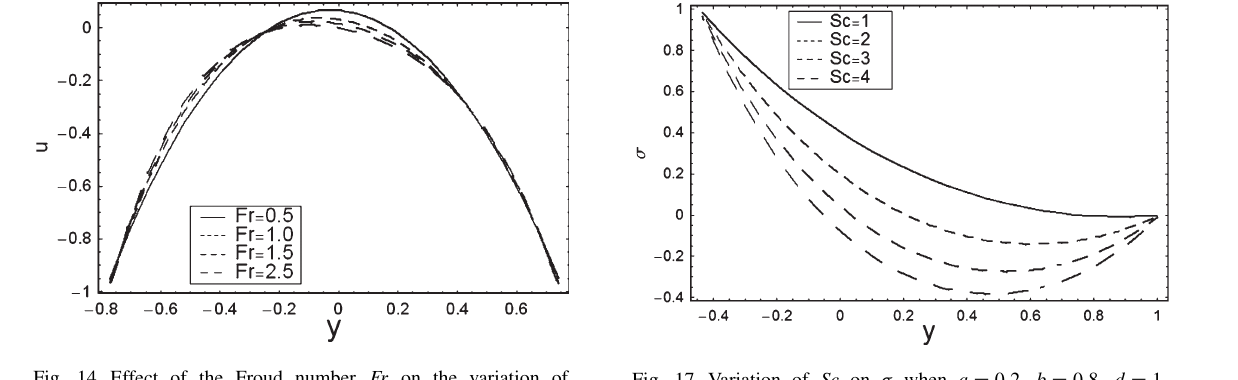
Fig. 17. Variation of Sc on σ when a = 0 . 2, b = 0 . 8, d = 1, β